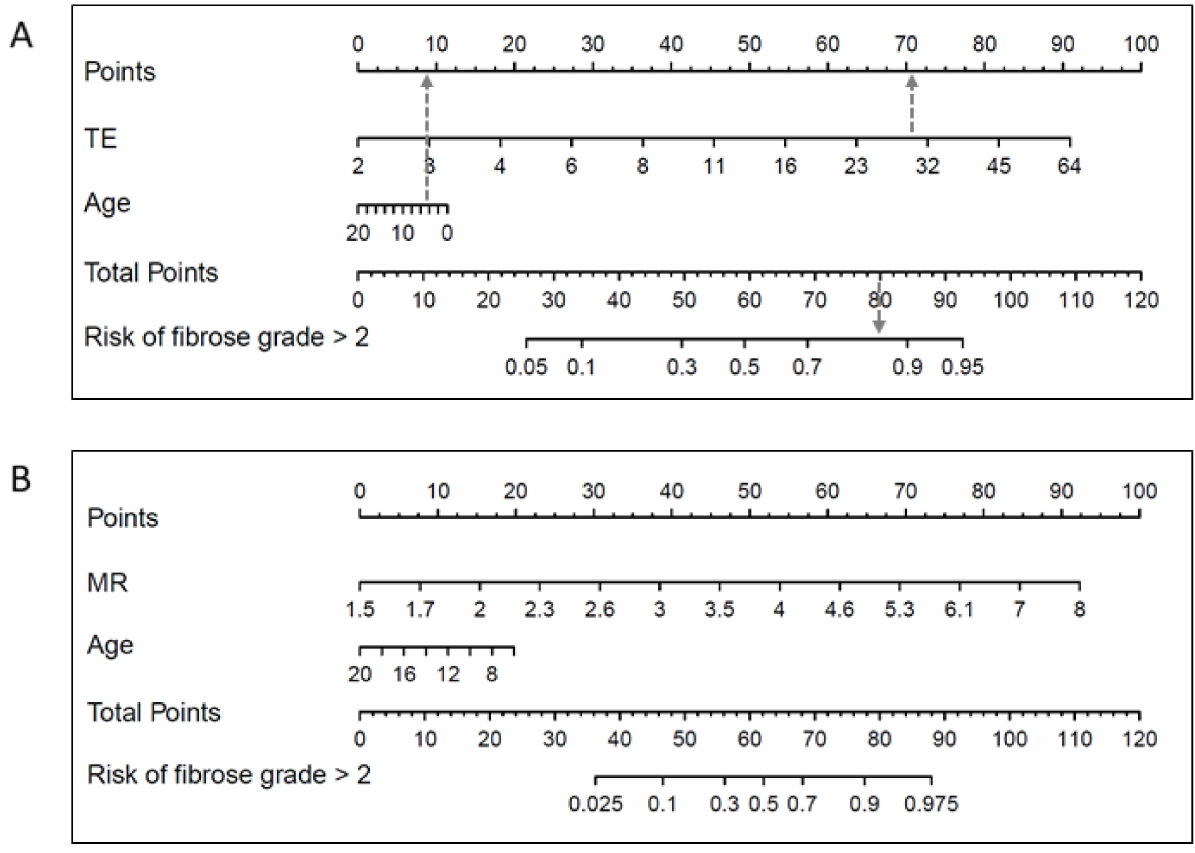
Figure 4. Nomograms for the prediction of advanced fibrosis (F3-4) based on TE results ( A ) and MRe results ( B ) in patients with pediatric liver disease. Grey dotted line: The risk of advanced fibrosis for a 4 year old child with TE result of 30 kPa is almost 0.9. TE: Transient elastography. MRe: Magnetic Resonance